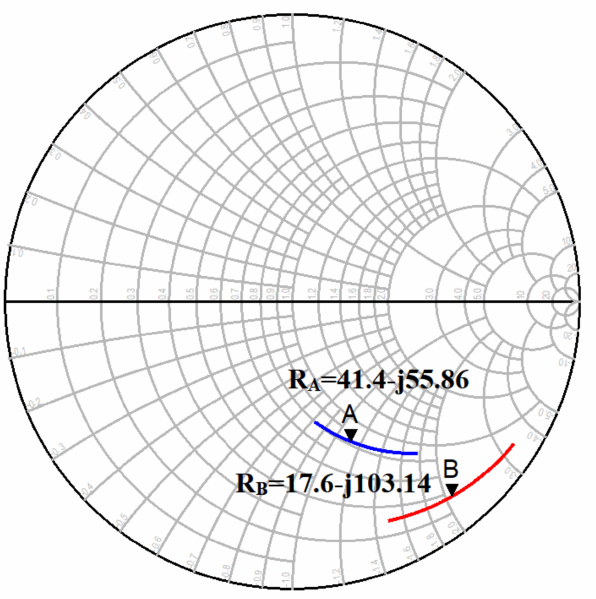
Figure 5. Input impedance with (A) and without (B) additional metal layers on the base